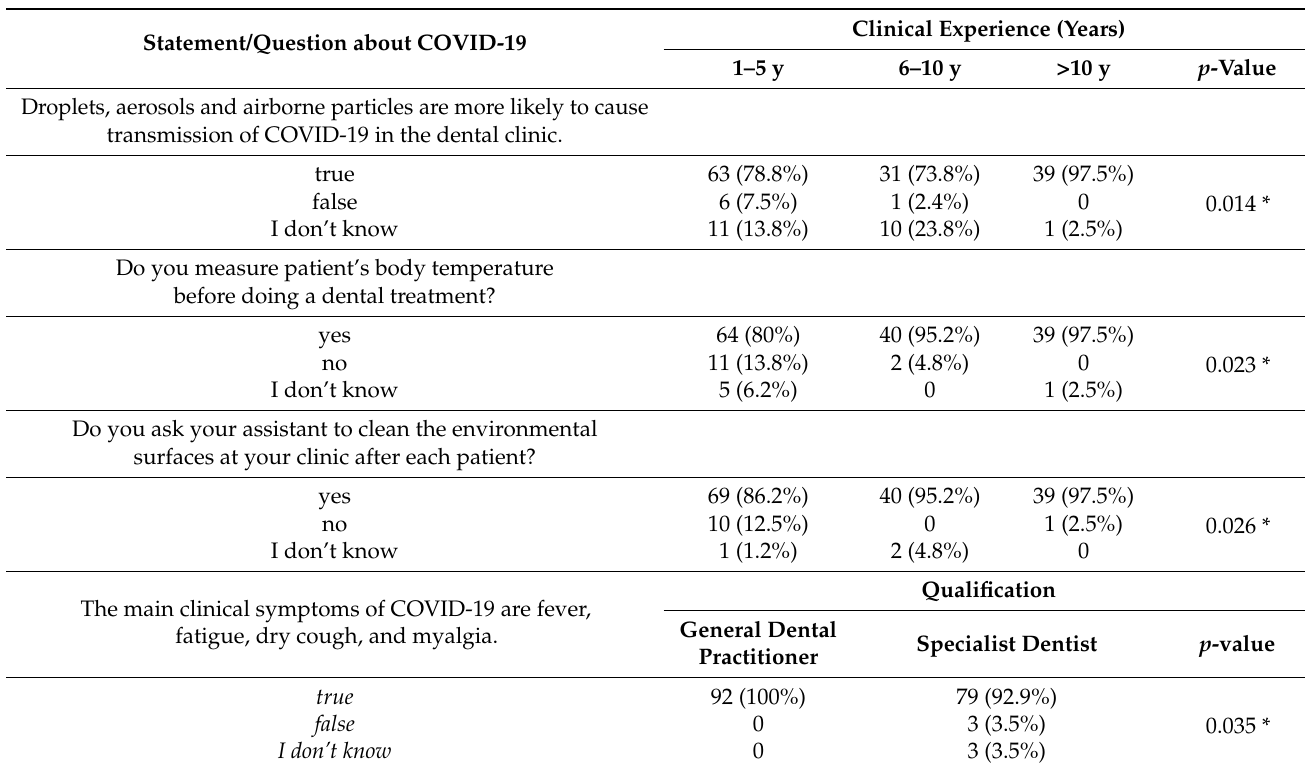
Table 4. Association between survey items and dentist’s clinical